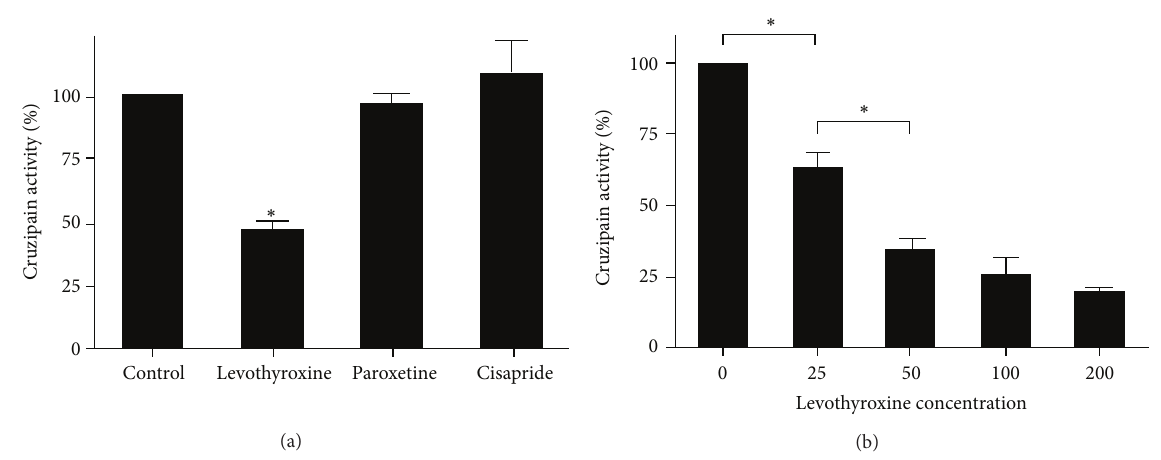
Figure 6: (a) Inhibitory effect of the three selected candidates on purified Cz activity. The final concentration of each compound was 50 𝜇 M. Protease activity is expressed as percentage of the control condition (2% DMSO). (b) Dose-dependent inhibitory effect of levothyroxine on purified Cz activity. Levothyroxine was assayed in a concentration range of 0–200 𝜇 M. Remanent Cz activity was expressed as a percentage respect to the control (0 𝜇 M levothyroxine, 2% DMSO). Asterisks indicate significant differences ( ∗ 𝑃 < 0.05 ).